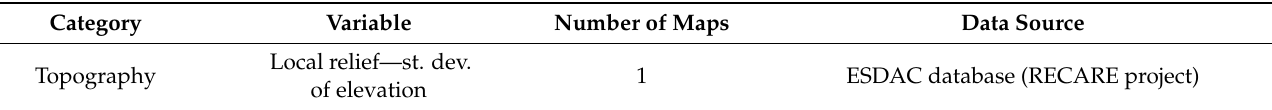
Table 1. Overview of PESERA input